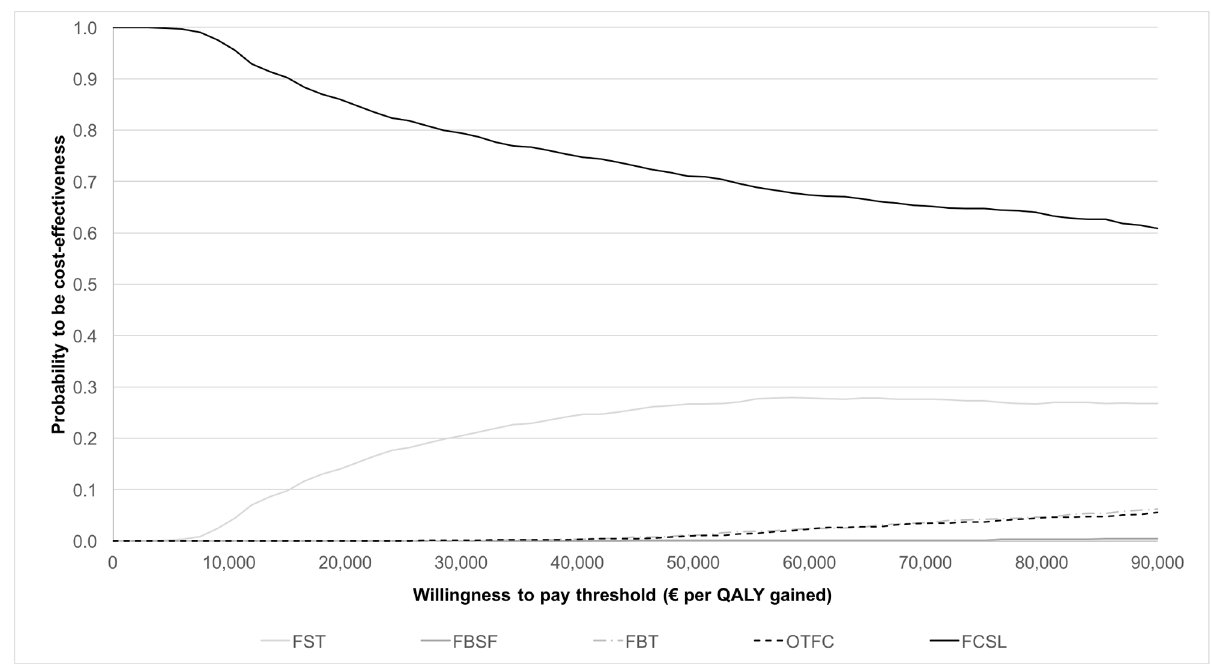
Fig 2. CEAC at base-casescenario. FCSL = SublingualFentanyl Citrate; FBSF = Fentanyl Buccal SolubleFilm; FBT = Fentanyl Buccal Tablet; OTFC = Oral Transmucosal Fentanyl Citrate; FST = Fentanyl SublingualTablets.